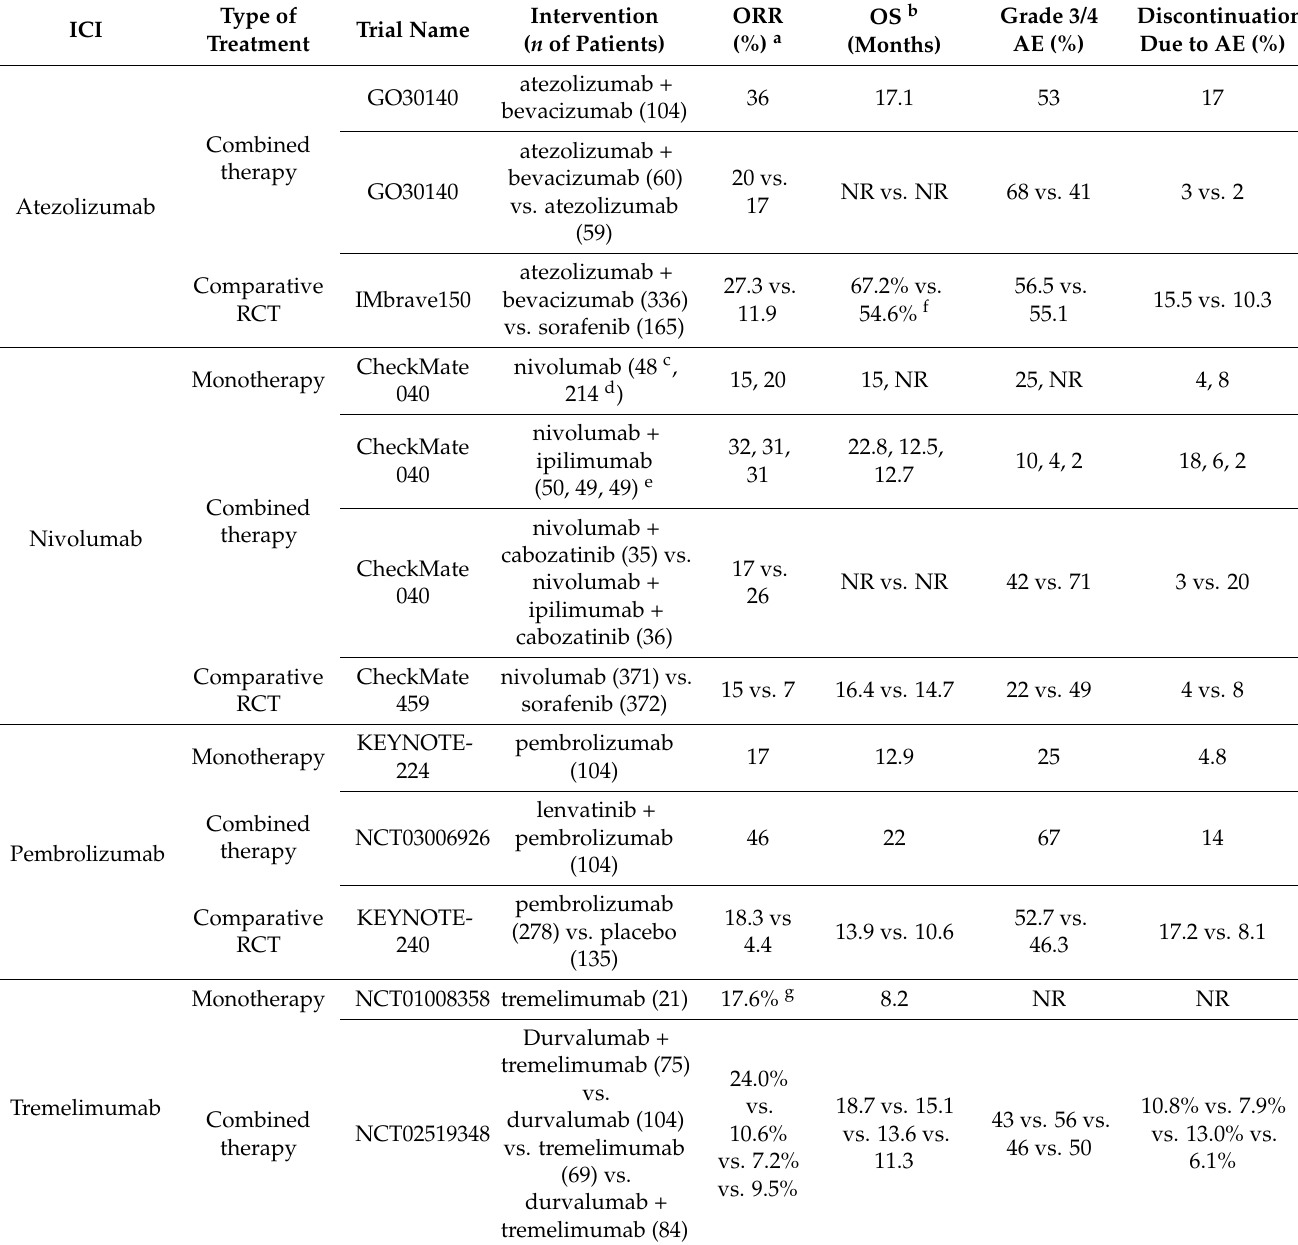
Table 1. Clinical trials assessing the safety and efficacy of ICI in patients with